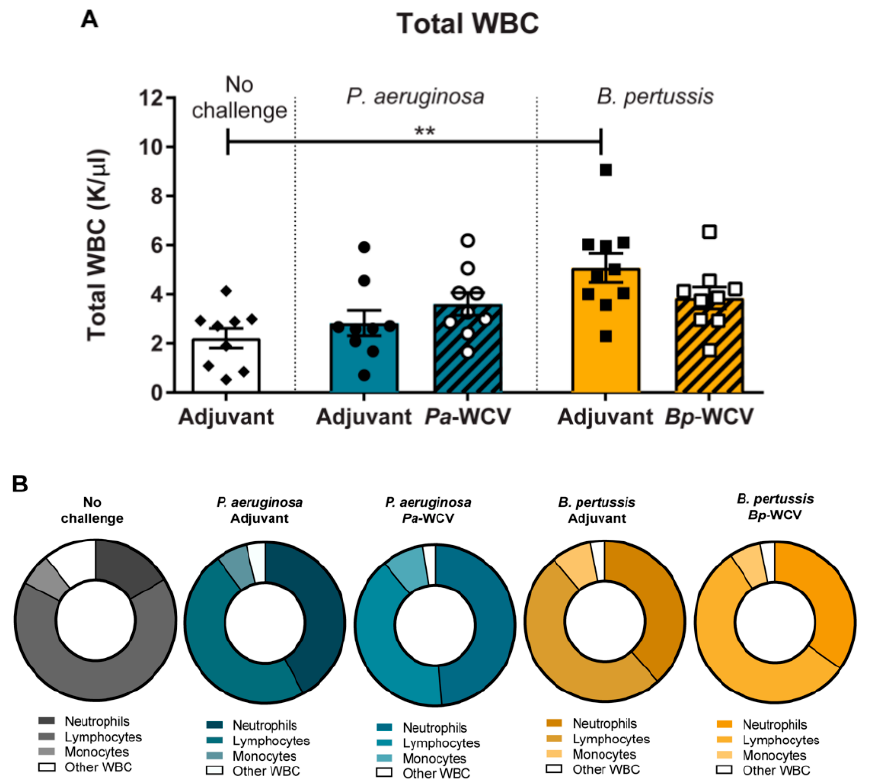
Figure 4. The proportion of blood cell populations after-challenge. ( A ) Total number of white blood cells. ( B ). Proportion of neutrophils, lymphocytes, and monocytes in total white blood cells ( n = 9–10 per group). The asterisks and bars indicate statistical significance determined by ANOVA: ** p ≤ 0.01.